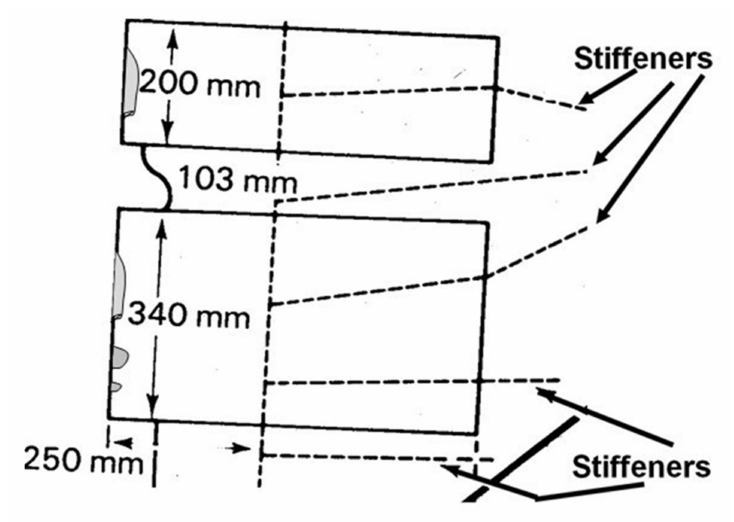
Figure 1. Schematic of outboard-edge disbonds (grey areas) at 923 air-flight hours in RAAF aircraft A15-5, from